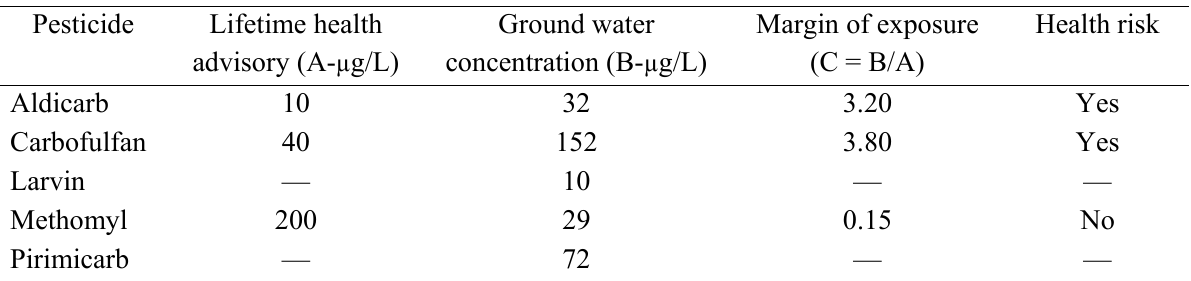
Table 2. Comparison of Pesticide Concentrations in Ground Water with Lifetime Drinking Water Health